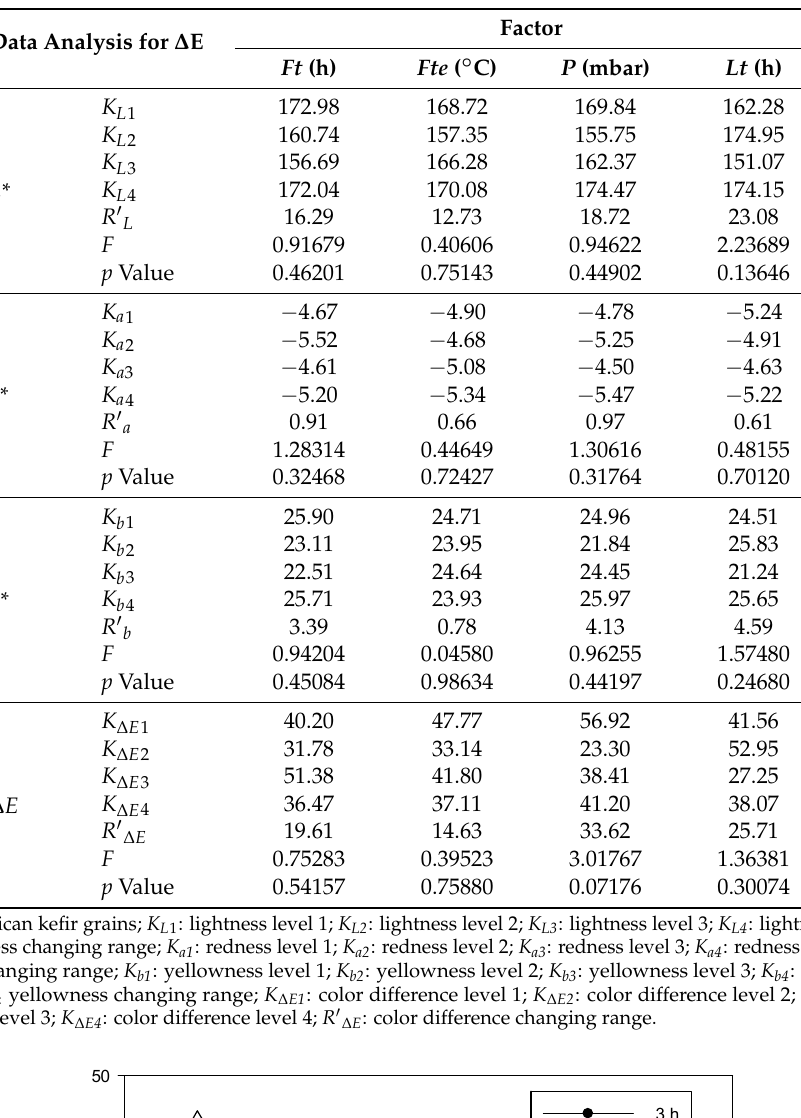
Table 6. Data analysis of MKG color difference ( ∆ E).